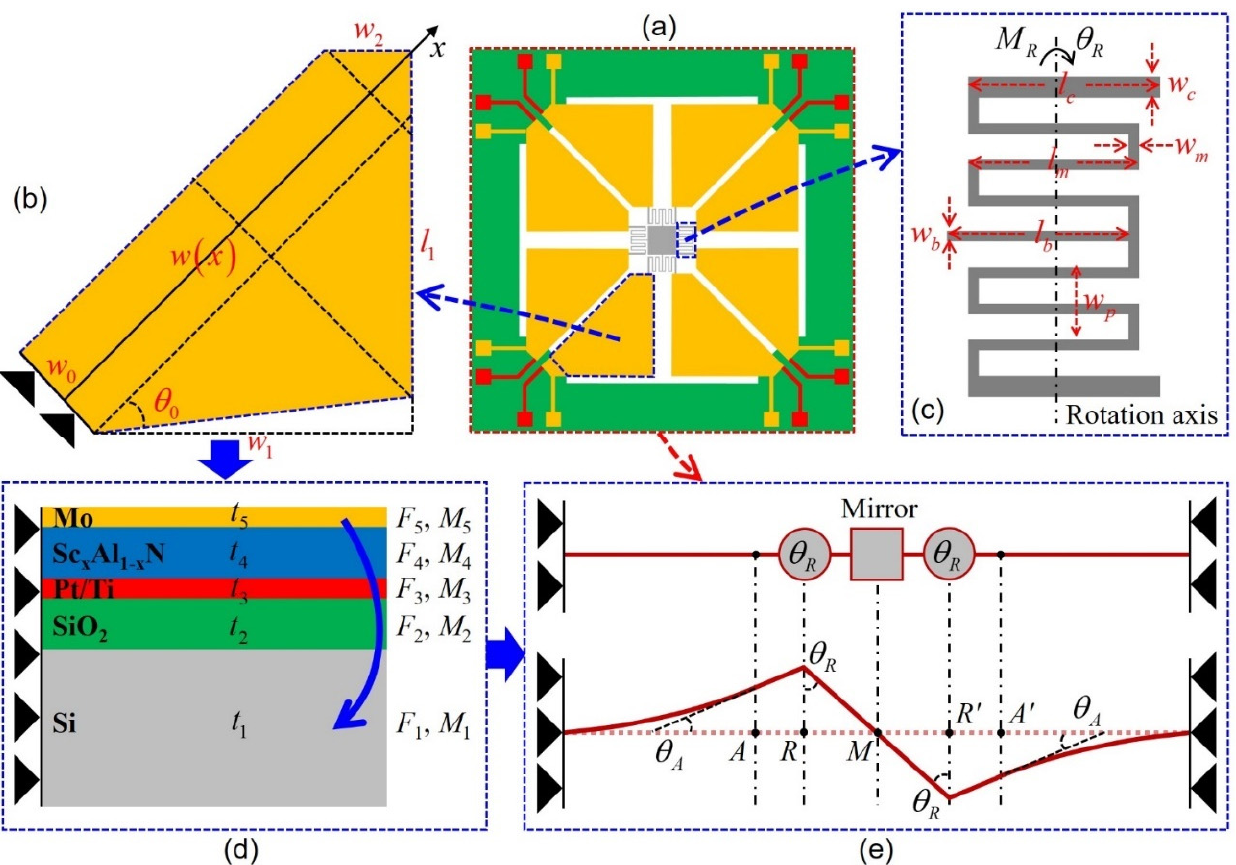
Figure 3. Simplified structural model of the trapezoidal Sc x Al 1-x N based actuators: ( a ) structure configuration of the MEMS mirror, ( b ) top view of the PM actuator, ( c ) design schematic of the meandering spring, ( d ) cross-sectional view of the PM actuator, ( e ) simplification of the MEMS mirror.